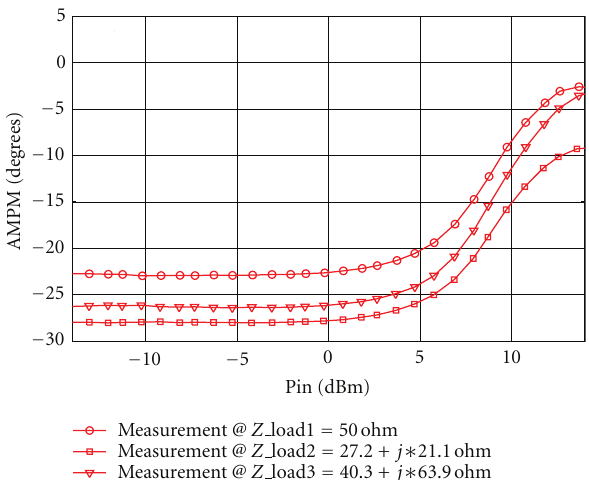
Figure 17: Gain compression (AMAM) versus input power for several loading impedances (Z load1 = 50ohm, Z load2 = 27 . 2 + j · 21 . 1, Z load3 = 40 . 3 + j · 63 . 9).